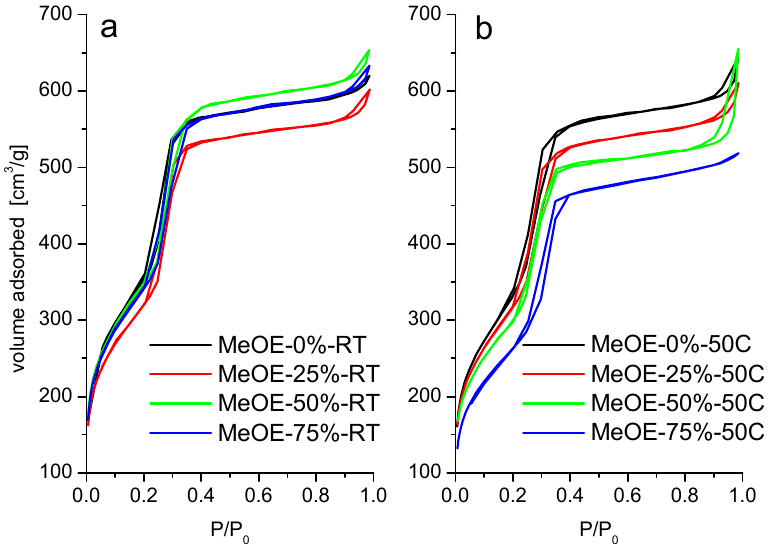
Figure 3. N 2 adsorption-desorption isotherms of calcined samples prepared at room temperature ( a ) and at 50 °C ( b ).